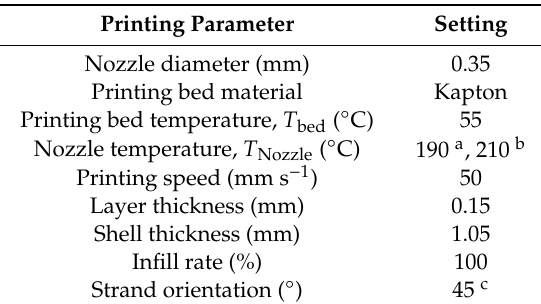
Table 1. Printer